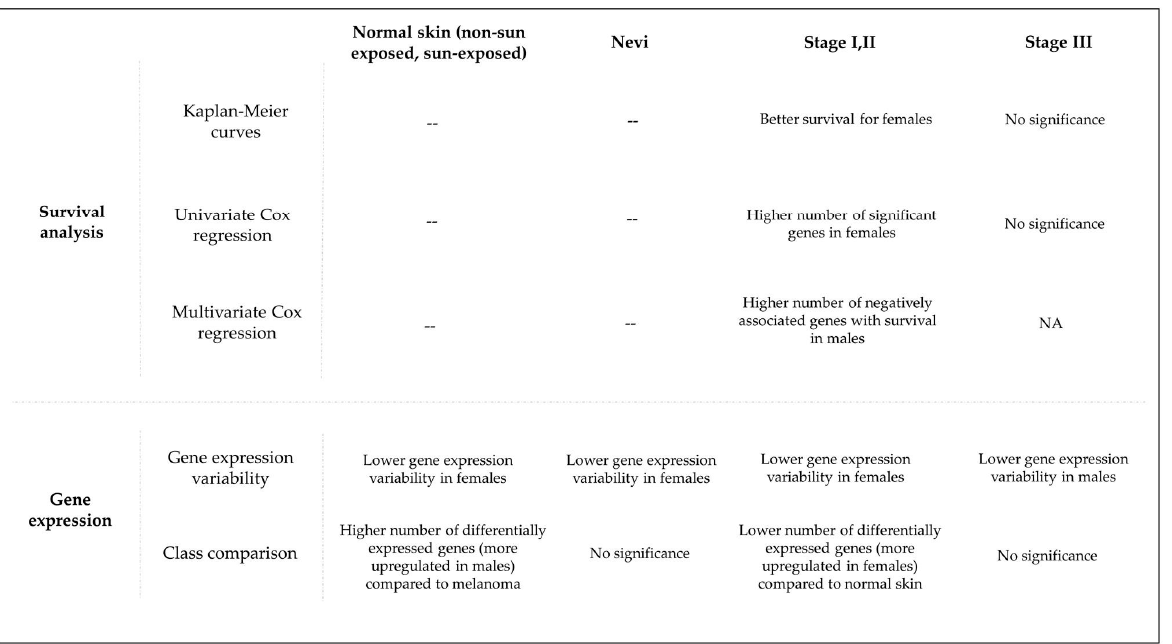
Figure 5. Summary of the methodologies and results of this